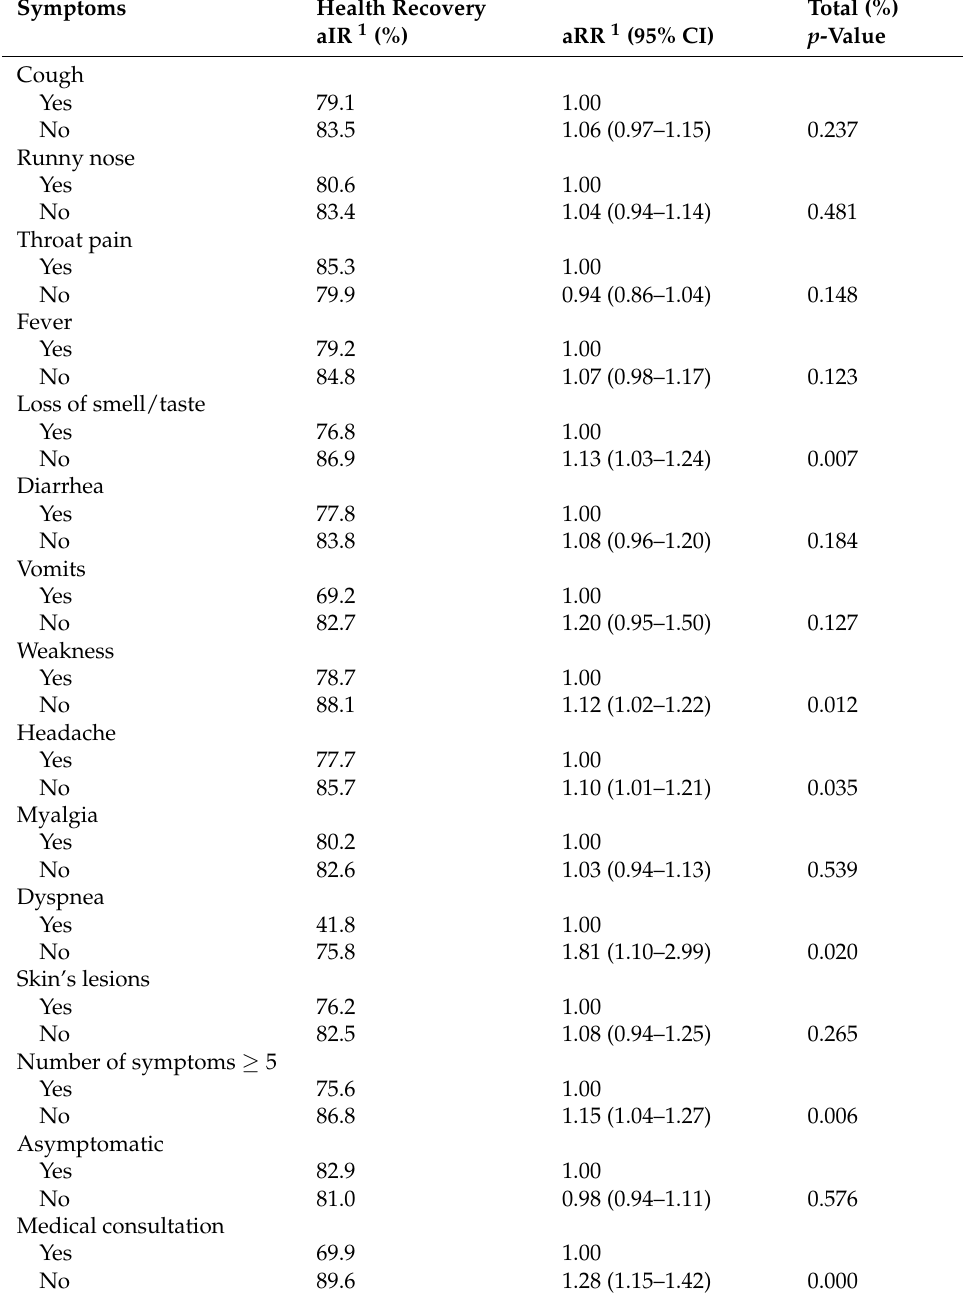
Table 4. Symptoms of acute COVID-19 illness and health recovery by adjusted incidence rate (aIR) and adjusted relative risk (aRR). Borriana COVID-19 cohort 2020.